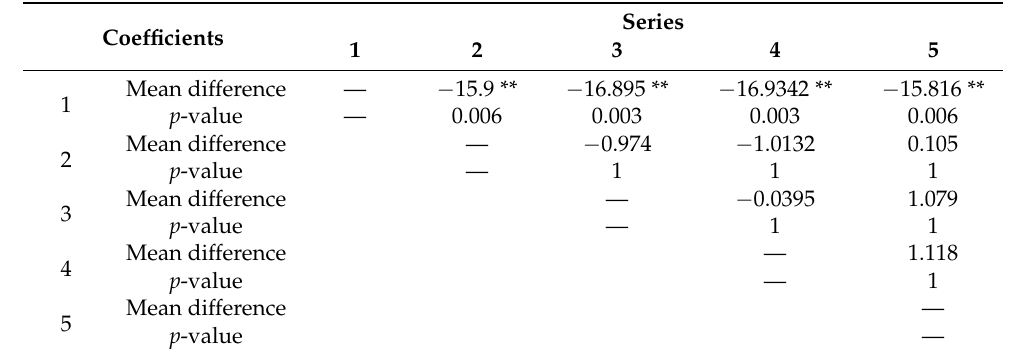
Table 5. Games–Howell post hoc test for ammonium nitrogen results.